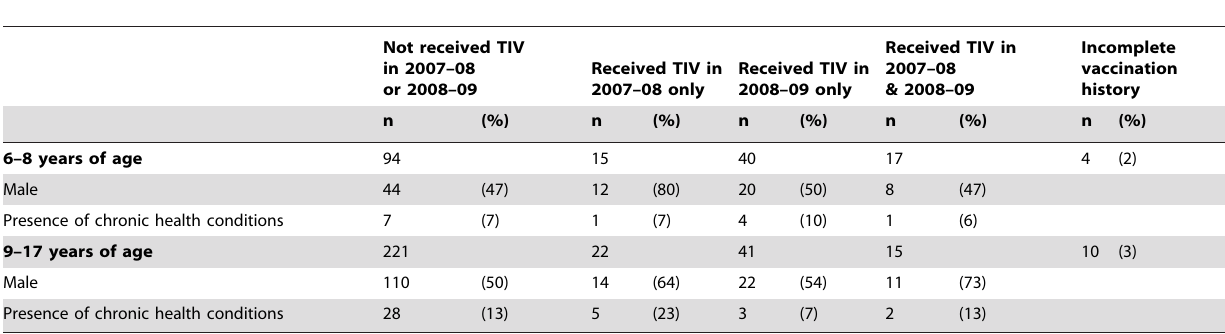
Table 2. Characteristics of 479 subjects randomized to receive trivalent inactivated influenza vaccine (TIV) in 2009–10 with regard to their vaccination history in 2007–08 and